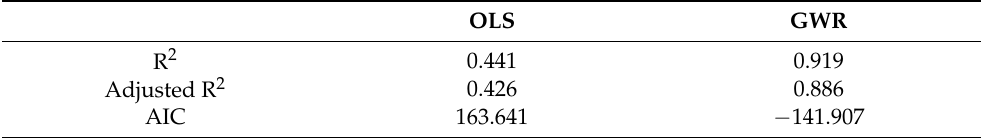
Table 3. Statistical test comparison of ordinary least squares (OLS) regression and geographically weighted regression (GWR).